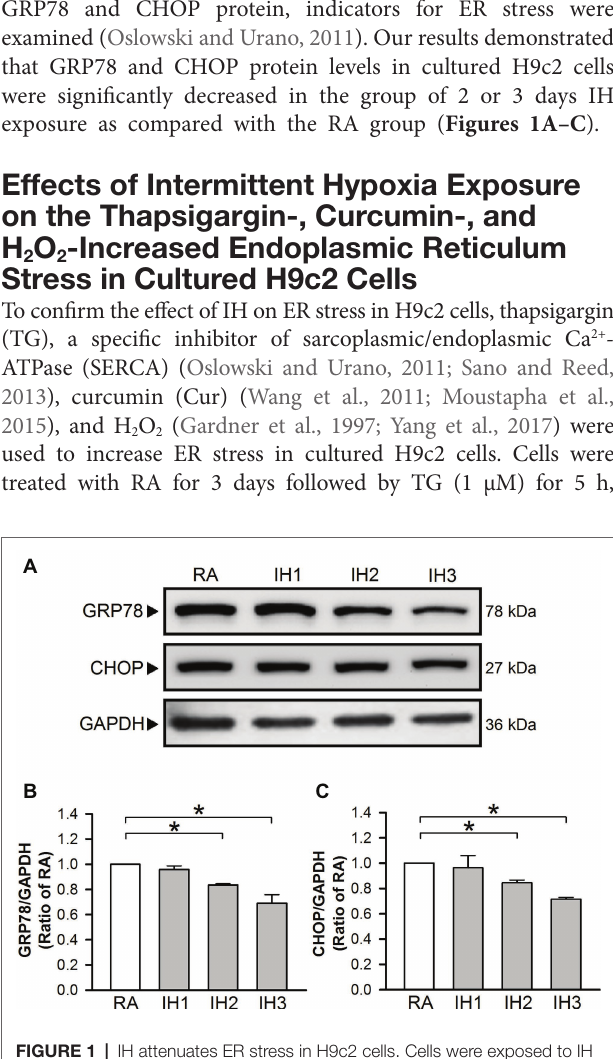
FIGURE 1 | IH attenuates ER stress in H9c2 cells. Cells were exposed to IH for 1–3 days, and then harvested for detecting the GRP78 and CHOP protein levels. (A) A representative result of GRP78, CHOP, and GAPDH protein levels determined by Western blot analyses. Quantitative results shown in (B) for GRP78 protein levels and (C) for CHOP protein levels were adjusted with GAPDH protein level and expressed as ratio over the RA group. Values are means ± SEMs. ( n = 4). * p < 0.05. IH, intermittent hypoxia; RA, room